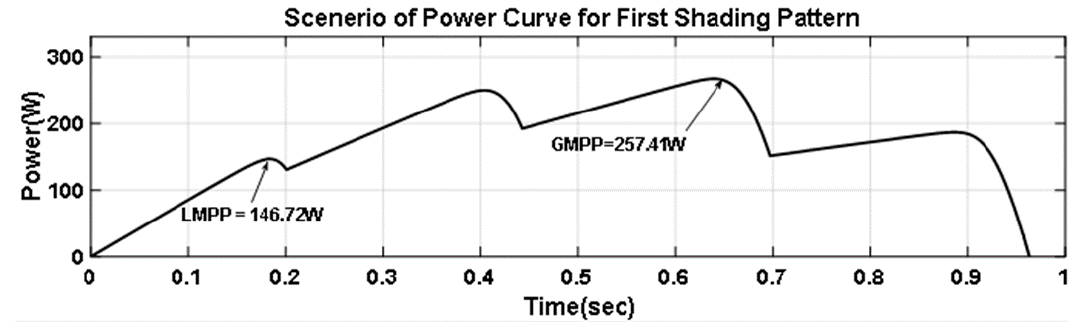
Figure 11. Scenario of Power curve under first shading pattern like 800 W/m 2 , 600 W/m 2 , 400 W/m 2 and 200 W/m 2 .